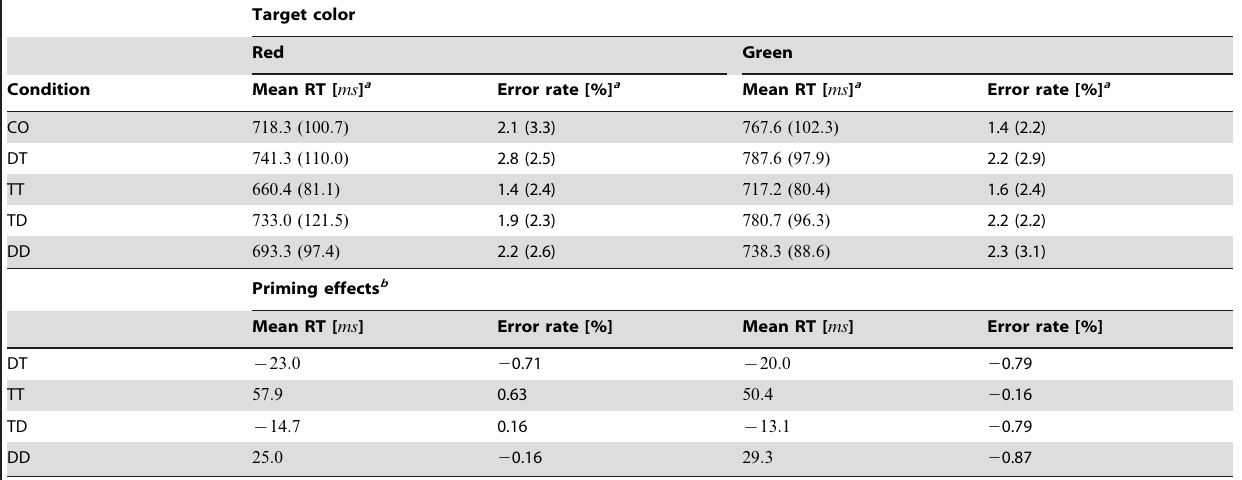
Table 1. Summary of results of Experiment 1.